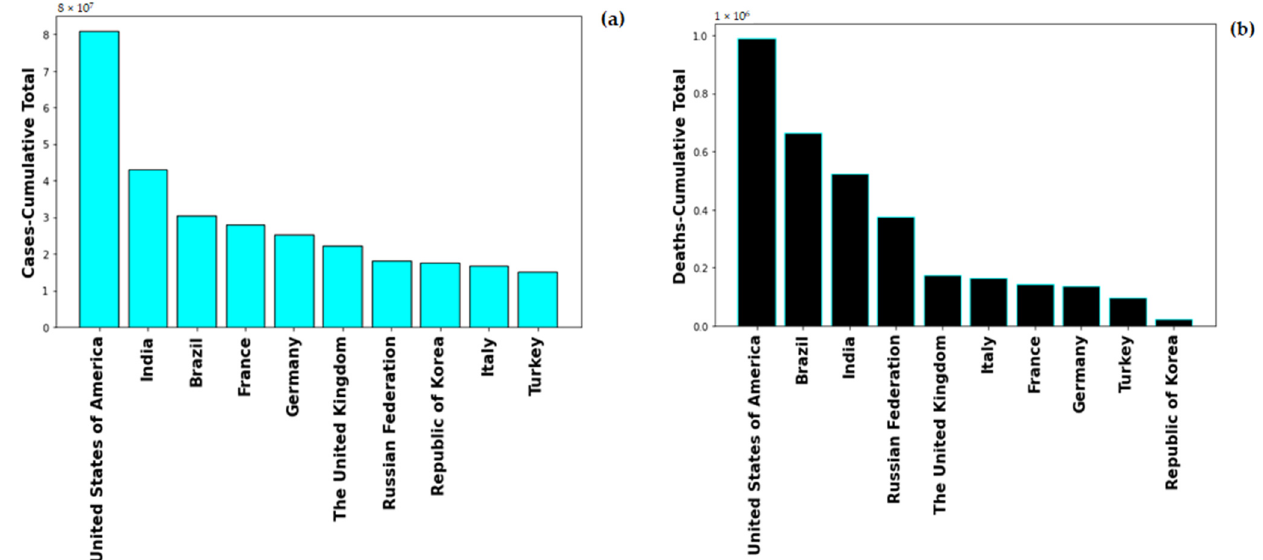
Figure 1. Total Number of ( a ) cases and ( b ) deaths for top 10 countries globally.